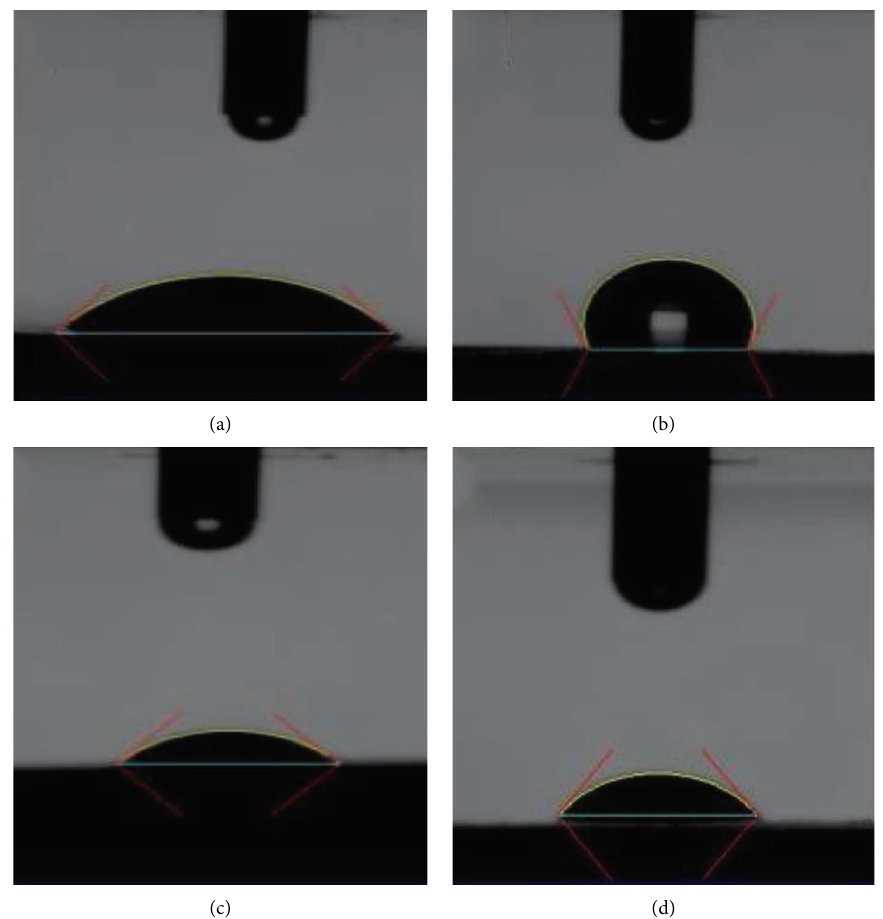
Figure 5: Water drops on the surface. (a) cp Ti-GO (hydrophilic). (b) cp Ti-NB (hydrophobic). (c) cp Ti-NBGO (hydrophilic). (d) cp Ti